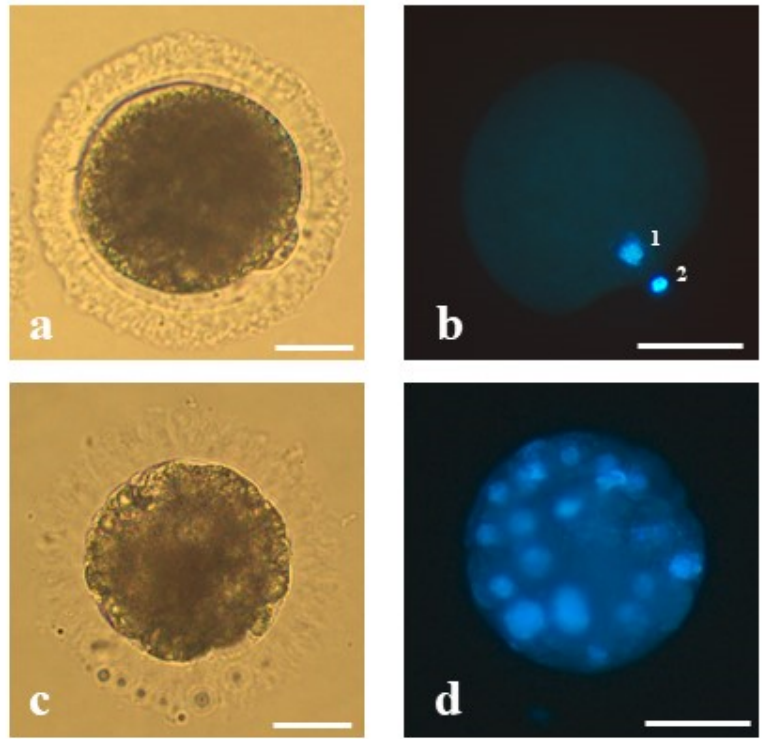
Figure 1. The representative oocyte and morula stage embryo of the domestic cat analyzed in the present study: ( a ) mature oocyte of proper morphology at the second metaphase stage with extruded first polar body, ( b ) mature oocyte stained with Hoechst 33,342—(1) visible chromatin of the oocyte and (2) the first polar body, ( c ) an embryo at the morula stage on 5 dpi derived from an oocyte matured in vitro, vitrified, fertilized by intracytoplasmic sperm injection and ( d ) stained with Hoechst 33,342. Bars represent 50 µm.